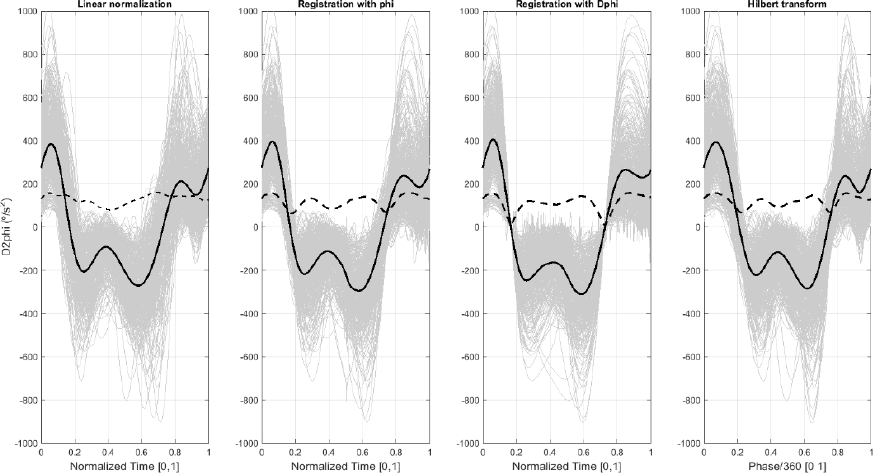
Figure 4. Normalized velocity (Dphi) curves for the four methods compared, together with their functional means (solid black line) and functional standard deviations (dashed black line).